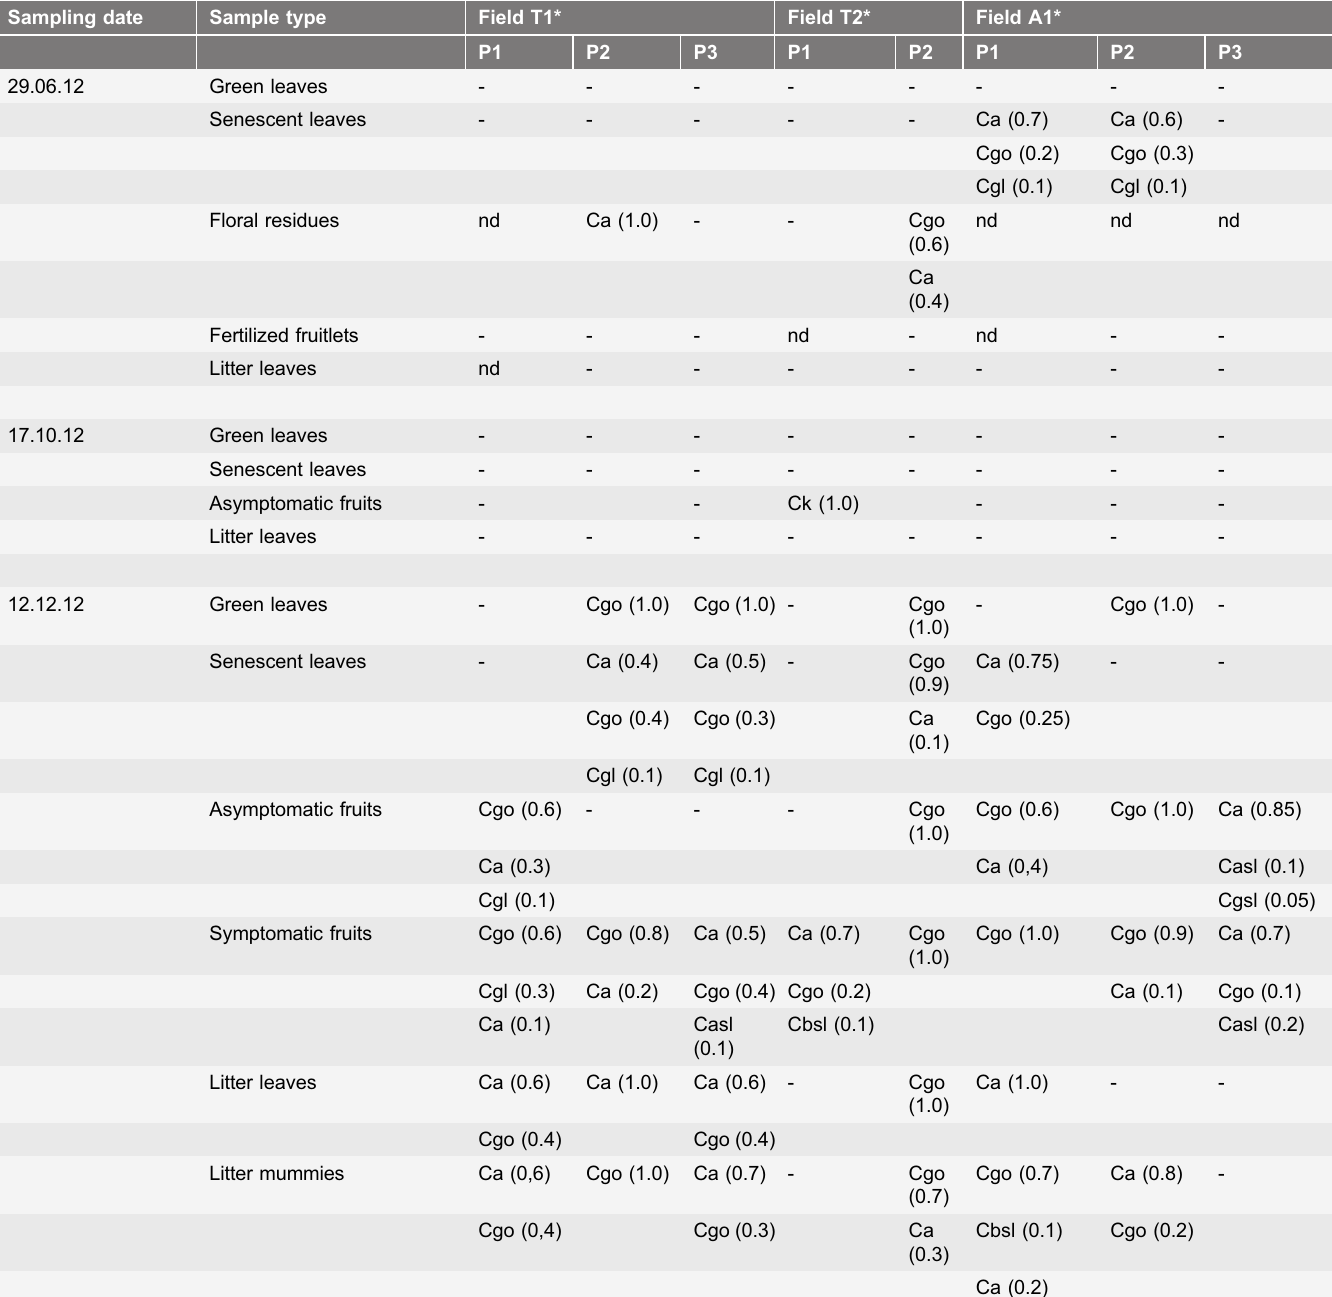
Table 2. Summary of results of field surveys conducted with different olive tissues collected in 3 phenological phases from 8 different plants located in three fields (T1, T2, A1). Sampling